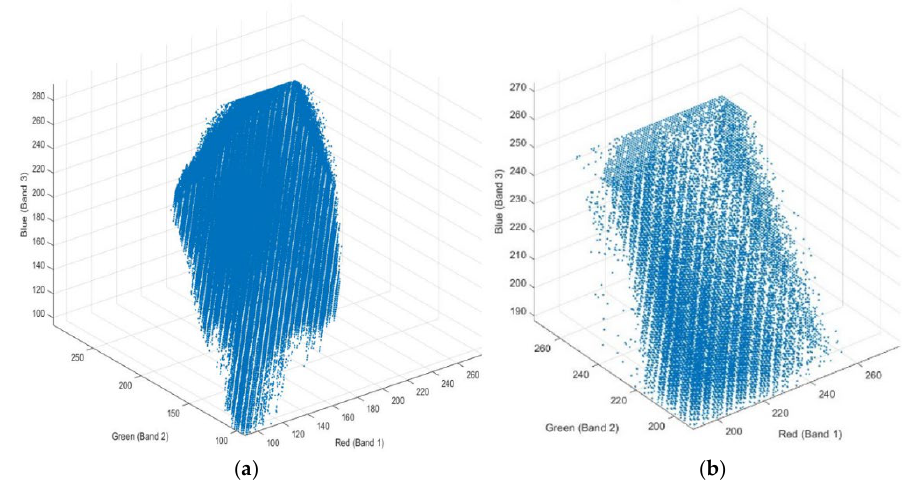
Figure 9. The 3D plot of R, G and B bands, ( a ) un-enhanced image, ( b ) image enhanced.